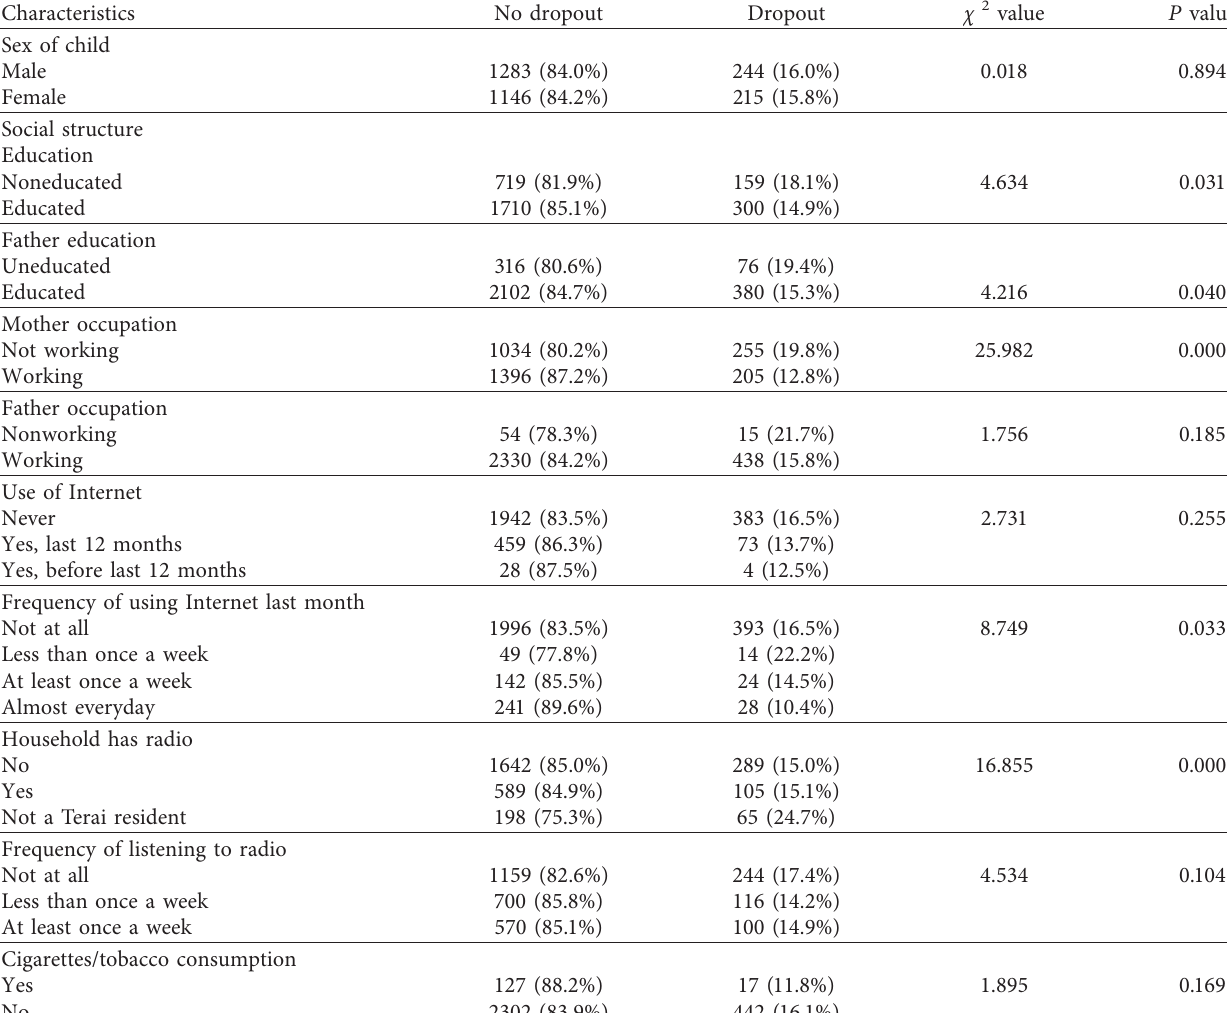
Table 3: Cross tabulation between predisposing factor and DPT1 Vs DPT3